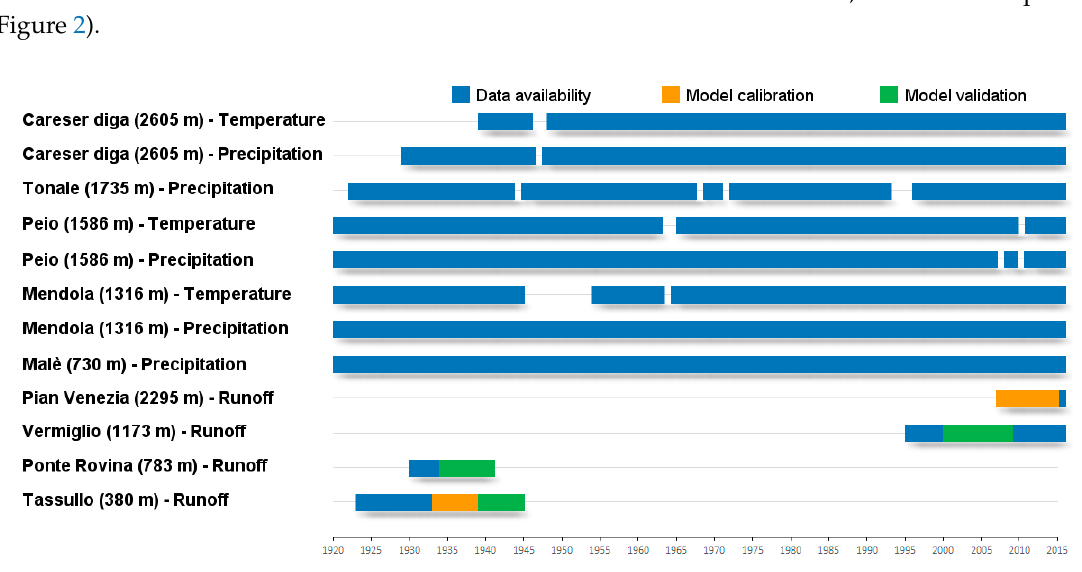
Figure 2. Availability of hydro-meteorological data in the study area.